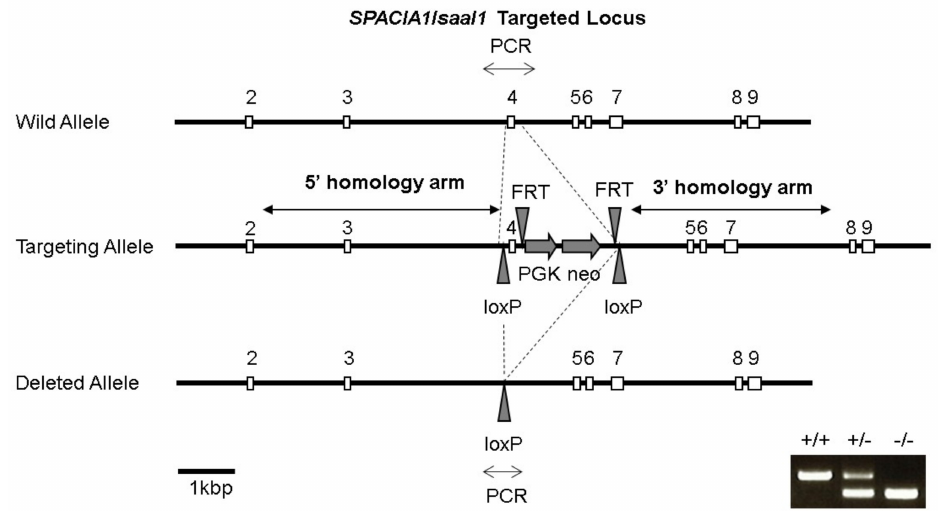
Figure 1. Schematic depiction of the SPACIA1/SAAL1 gene-targeting strategy. Homologous recombination resulted in exon 4 being flanked by loxP sites; deletion was achieved by Cre recombinase-mediated excision. The “ +/+ ”, “ +/ − ” and “ − / − ” indicate wild-type (wt), heterozygous and homozygous mice for the SPACIA1/SAAL1